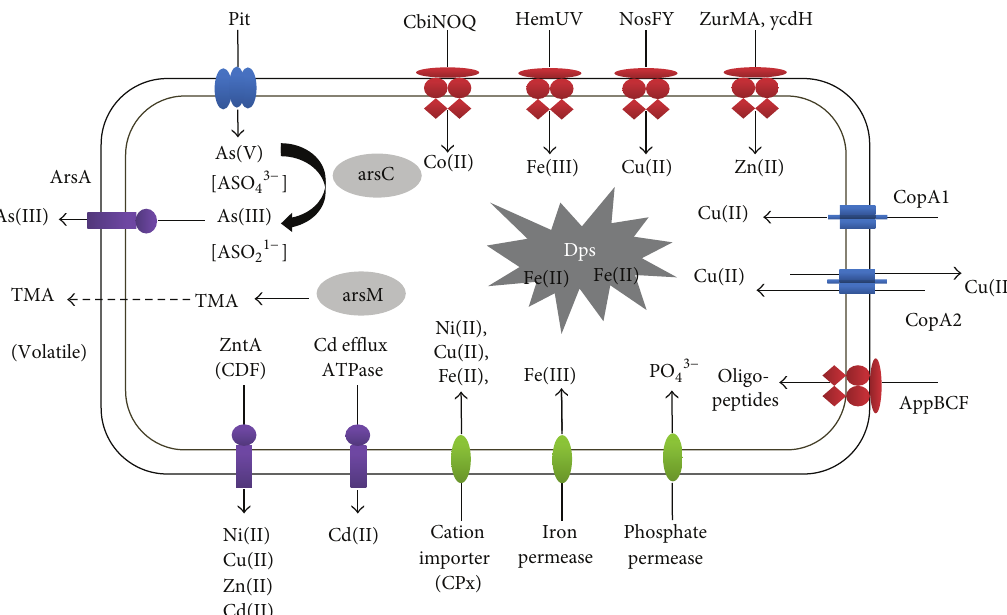
Figure 3: Various transporters playing a role in metal transport, homeostasis maintenance, and resistance in Halobacterium sp. strain NRC-1 , reported to date. The efflux pumps of ATPases and CDF family involved in Cd, Ni, Cu, Zn, Cd, and arsenite transport are represented in purple. ABC transporters (represented in red) involved in metal uptake are many. Certain toxic metals that do not have a dedicated uptake system may gain entry into the cell through other ABC transporters like oligopeptide and phosphate transporters. For example, the arsenate oxyanion gains entry into the cell through the pit/pst phosphate transporters due to its structural similarity to phosphate. The metal ions upon uptake can be detoxified either by enzymatic detoxification (ArsC and ArsM) or by chelation by peptides like Dps (DNA-binding protein of nutrient starved